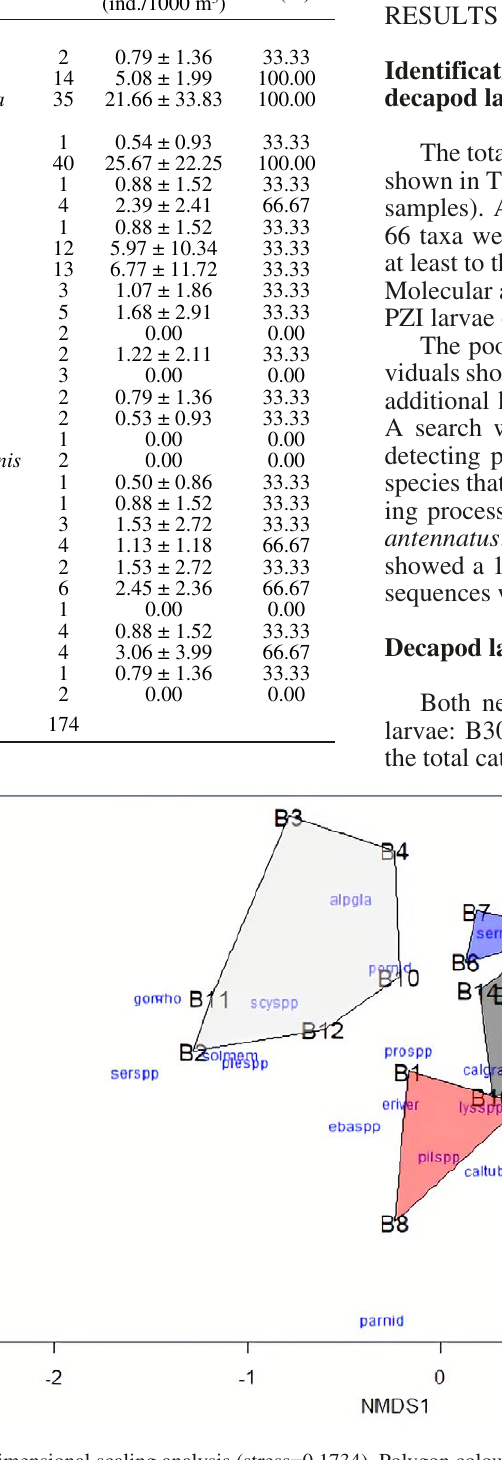
Fig. 2. – Non-metric multidimensional scaling analysis (stress=0.1734). Polygon colours indicate canyon zones: upstream wall (white), can- yon axis (blue), downstream wall (grey), canyon head (red). Station B13, with no decapod larvae, is not shown. Ariant, Aristeus antennatus ; sernid, Sergestidae; serspp, Sergia spp.; seratl , Sergestes atlanticus ; solmem, Solenocera membranacea ; siccar, Sicyonia carinata ; alpgla, Alpheus glaber ; euaspp, Eualus spp.; lysspp, Lysmata spp.; prospp, Processa spp.; plespp, Plesionika spp.; passpp, Pasiphaea spp.; carnid, unidentified Caridea; darspp, Dardanus spp.; caltub, Calcinus tubularis ; anaspp, Anapagurus spp.; galspp, Galathea spp.; scyspp, Scyllarus spp.; upospp, Upogebia spp.; pornid, Portunidae; pisnid, Pisidae; inanid, Inachidae; xthnid, Xanthoidea; xannid, Xanthidae; xanspp, Xantho spp.; parnid, unidentified Parthenopidae; gonrho, Goneplax rhomboides ; ebaspp, Ebalia spp.; pilspp, Pilumnus spp.; calgra, Calappa granu- lata ; eriver, Eriphia verrucosa ; moncou, Monodaeus couchii ; branid, unidentified Brachyura. Data from